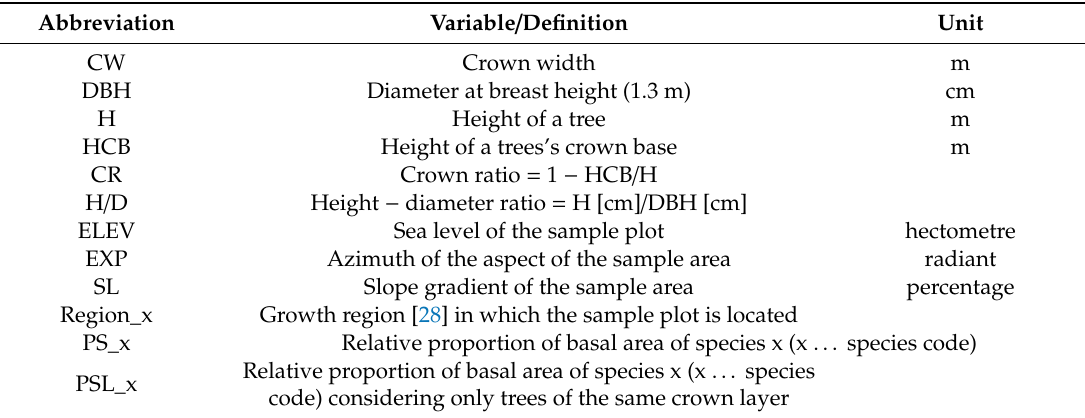
Table 1. List of variables, their abbreviations, and